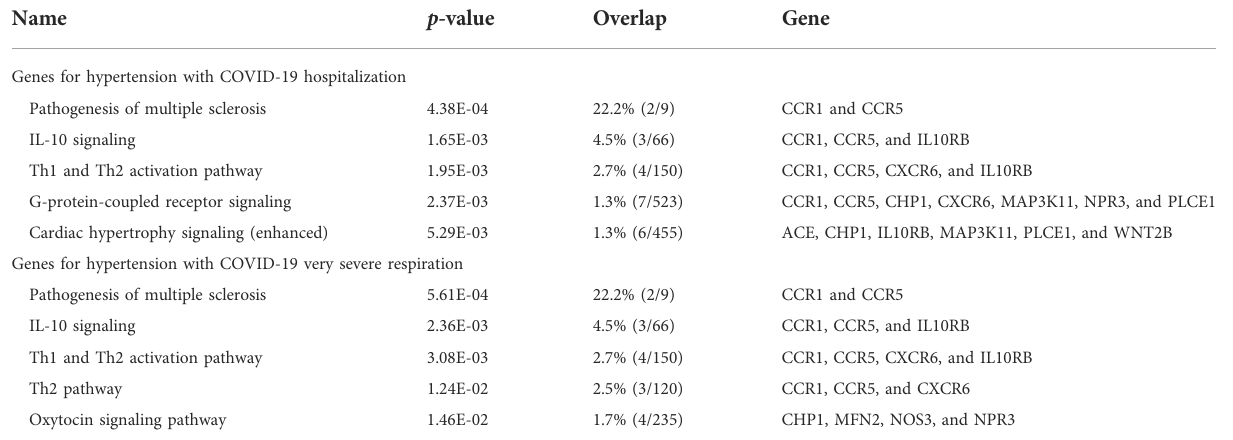
TABLE 3 Top Canonical pathways identi fi ed with